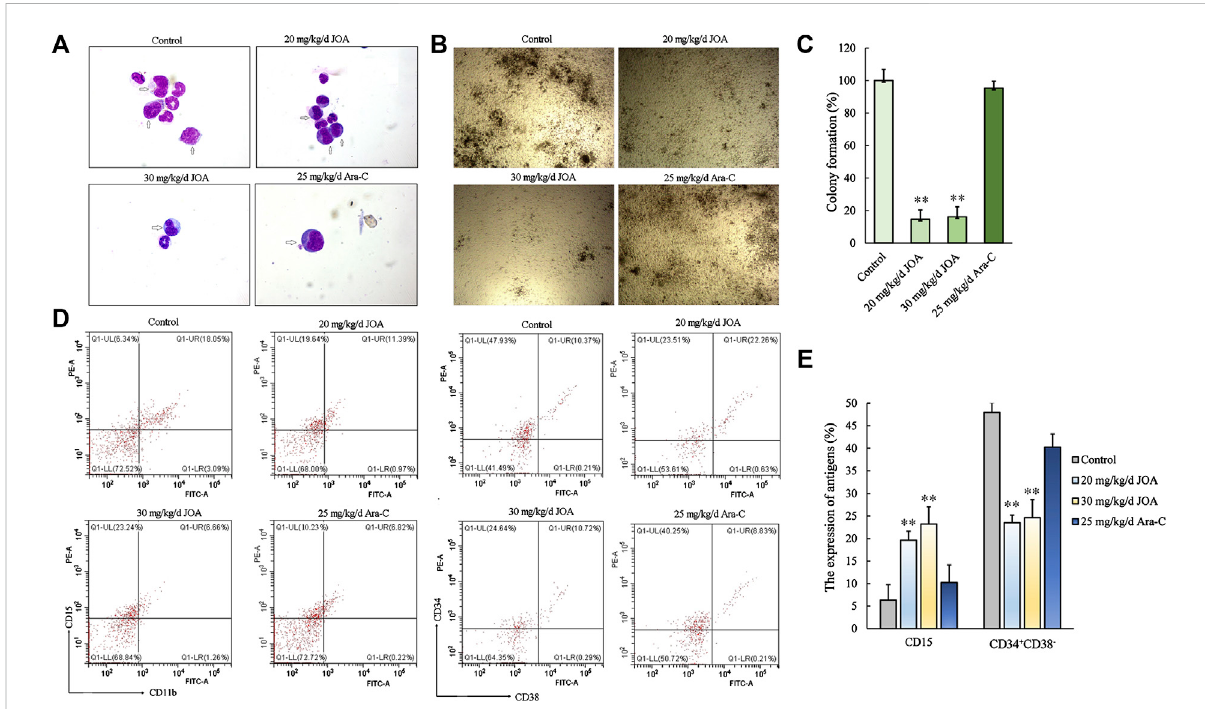
FIGURE 8 JOA inhibited theproliferation of leukemic stem-like cells in theMUTZ-8 cell xenograft inthe NOD/SCIDmousemodel. (A) Bone marrow cells were stained with Wright – Giemsa staining, and the morphology of leukemia cells (marked by arrows) was observed. (B) Colony formation ability of mononuclear cells from the bone marrow of mice. (C) Graph bars showing the colony formation number (** p < 0.01). (D) Expression of CD11b (FITC)-CD15(PE)andCD34 + CD38 − cellsinthemononuclearcellfromthebonemarrowofmice.TheCD34 + CD38 − cellsweredetectedby fl ow cytometry, in which the CD34 antibody was PE-labeled and the CD38 antibody was FITC labeled. (E) Graph bars showing the expression of antigens (** p <